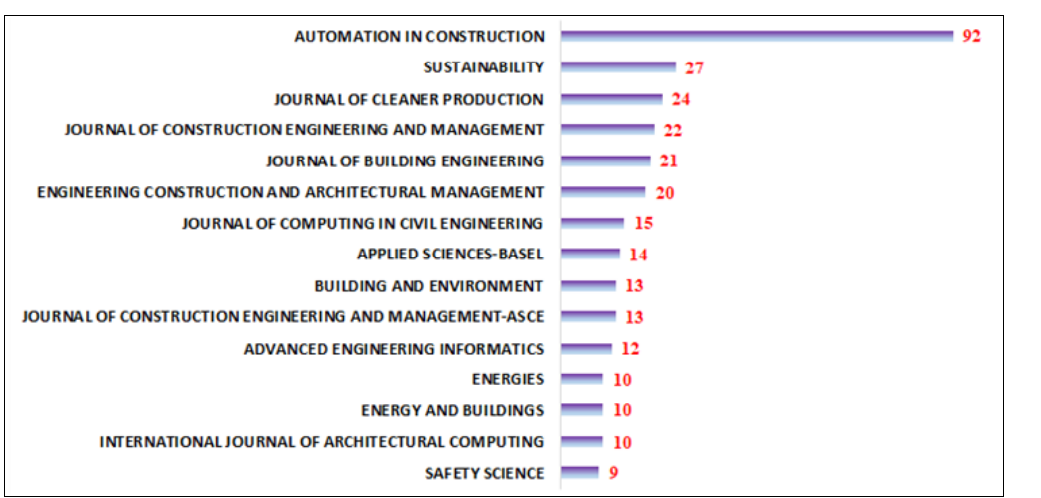
Figure 9. Number of articles published in the top 15 journals.